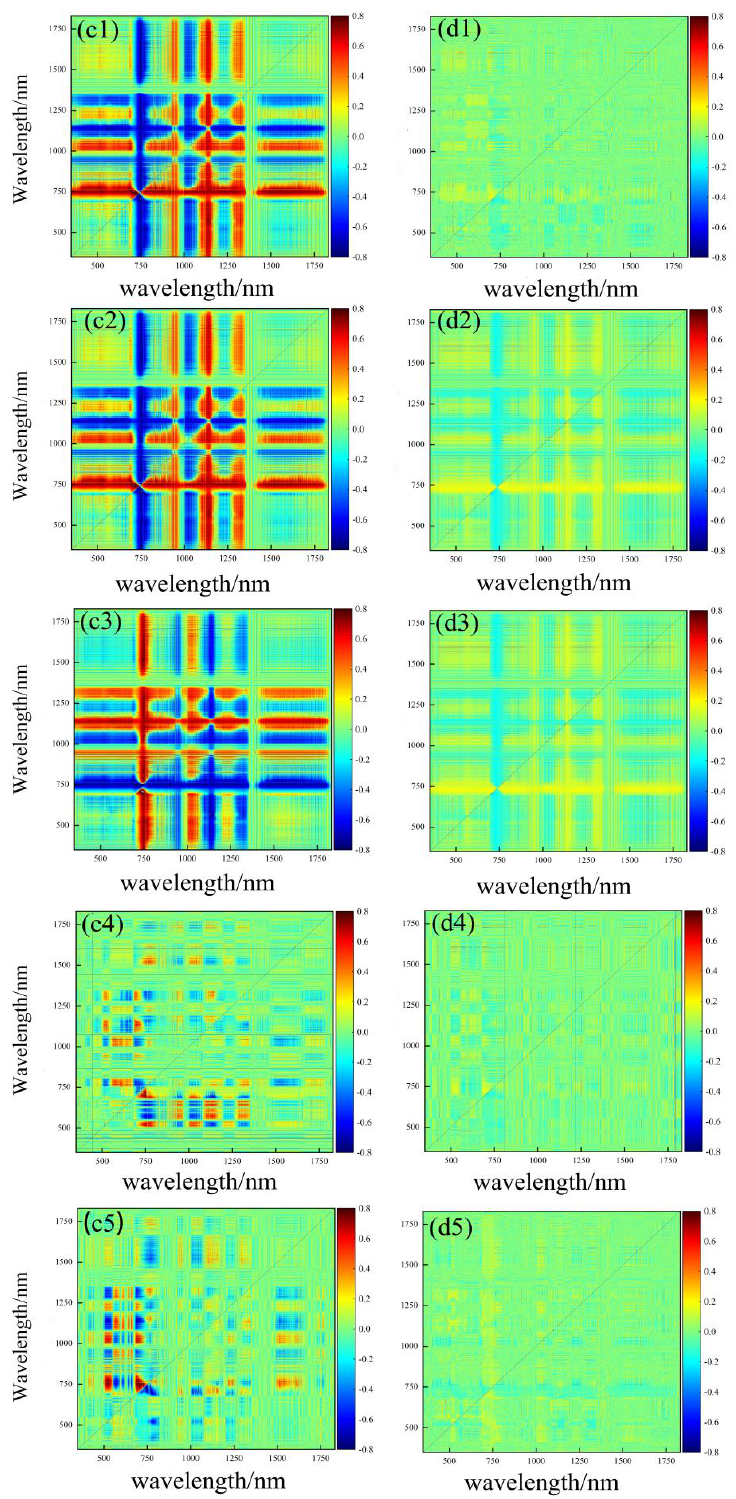
Figure 5. Correlation matrix diagram of spectral index and soybean chlorophyll content at different growth stages (( c1 – c5 ): R4 growth period DI, SAVI, TVI, mSR, and RI and soybean chlorophyll content correlation matrix; ( d1 – d5 ): R6 growth period NDVI, SAVI, DI, RI and mNDI and soybean chlorophyll content correlation matrix).